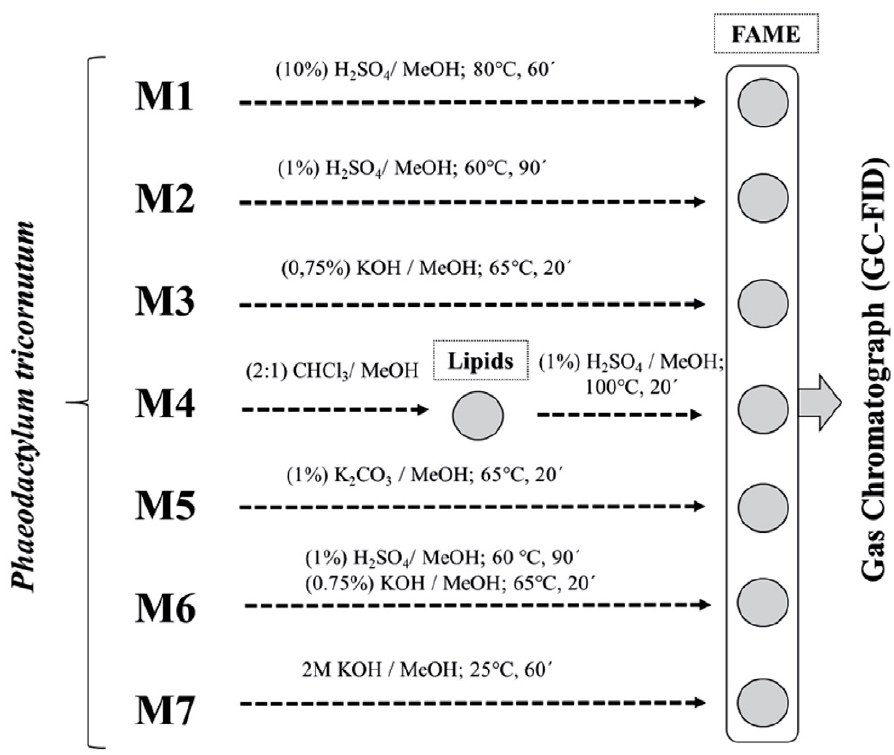
Fig. 1 Experimental design using P. tricornutum to obtain FAME. M1–M7 are the abbreviations of seven independent transesterification methods used in the study, as described in Material and Methods section ( p < 0.05; n =